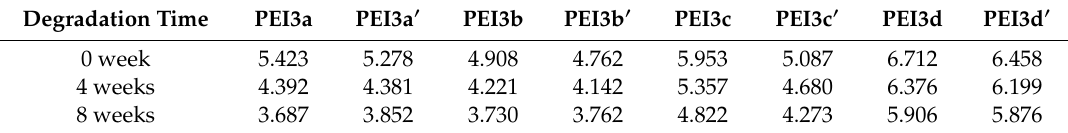
Figure 9. Weight average molecular remaining of PEI3a–PEI3d ′ in every stages of degradation. Table 5. Weight average molecular (M w × 10 4 ) of PEI3a–PEI3d (cid:48) at every stage of